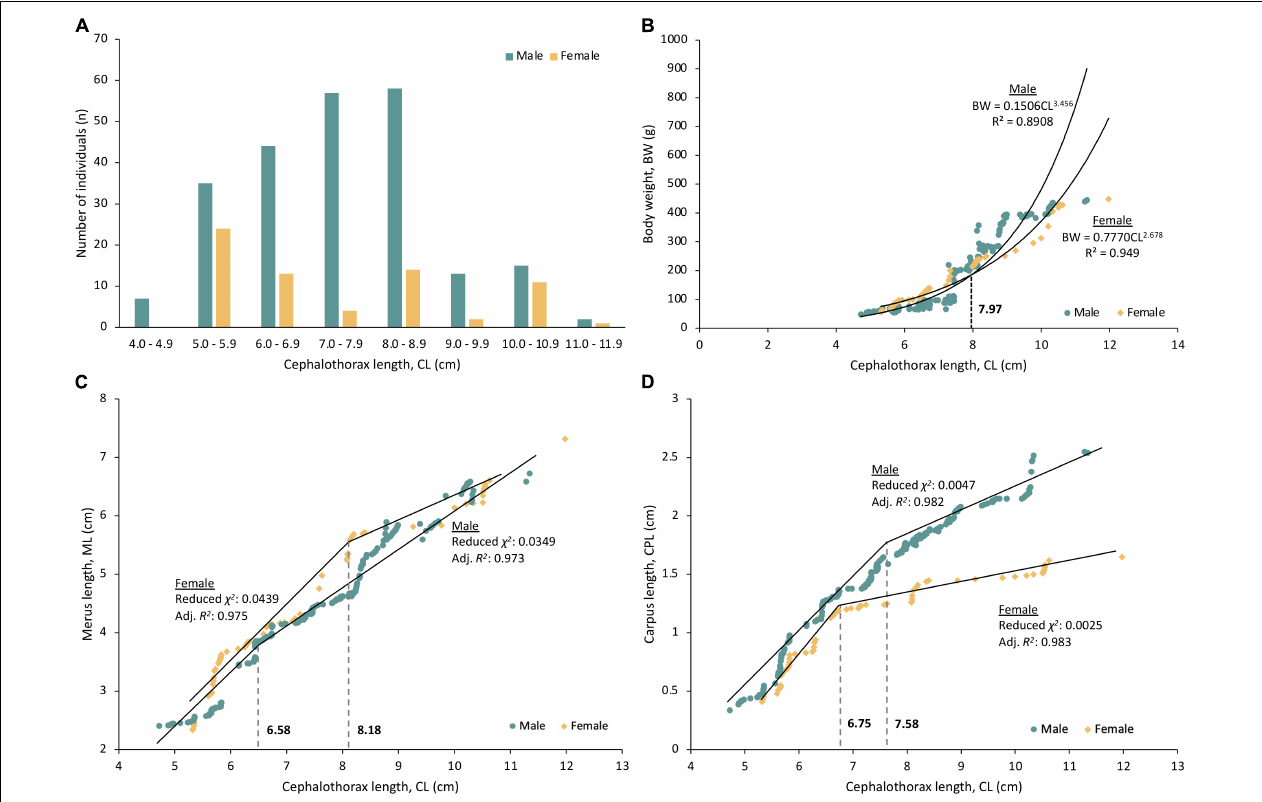
FIGURE 1 | The (A) Size distribution, (B) Length-weight relationship, (C) Estimated size at morphometric maturity based on merus length (ML), and (D) Estimated size at morphometric maturity based on carpus length (CPL) of the third walking leg of mud spiny lobster. Fitting of ML and CPL with CL in both sexes was successful ( F -test: all p < 0.001), and the estimated size at morphometric maturities was indicated using gray dotted line between the two regression lines of immature and mature specimens.